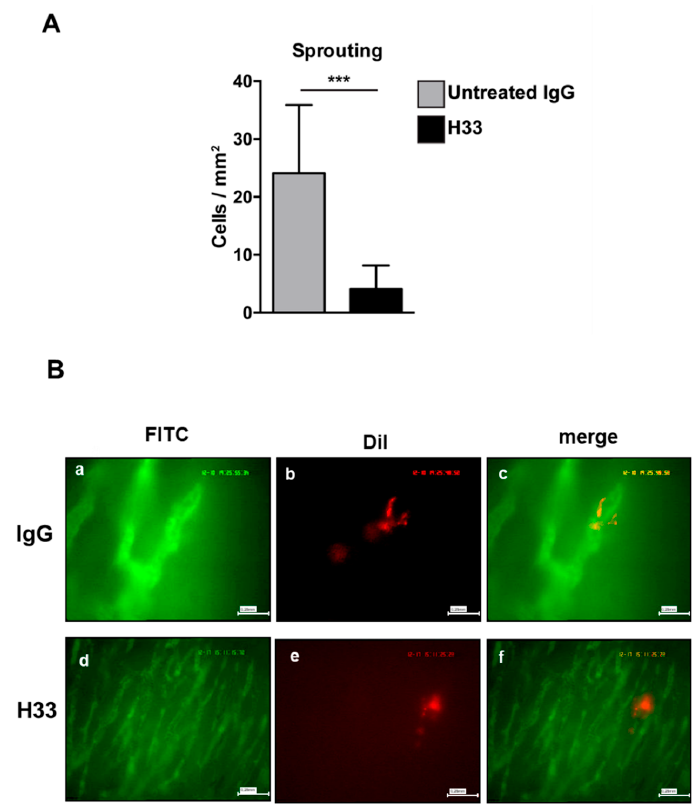
Figure 6. Monoclonal antibody blocking JAM-C a ff ected e-EPC cell morphology in vivo. Mice were treated as described in Figure 5. e-EPC cell morphology ( A ) was analyzed by counting cells showing elongated and polarized shapes. Morphological changes were significantly reduced in the anti-JAM-C H33 group compared with the isotype control antibody 9B5 treated group. Data are represented by mean ± SD (*** p < 0.01 H33 vs. IgG; IgG: n = 14, H33: n = 16). ( B ) Representative images of recruited e-EPC for each group (IgG, H33) on day 2 after cell injection. Tumor microvasculature after contrast enhancement by FITC-dextran (Fluorescein isothiocyanate-dextran) (a, d); DiI-labeled e-EPCs in the same regions of interest (b, e); merged images (c, f) showing e-EPCs characterized mostly by a rounded shape in the H33 group, in comparison with cells recruited in the control IgG-treated mice, which were characterized by an elongated